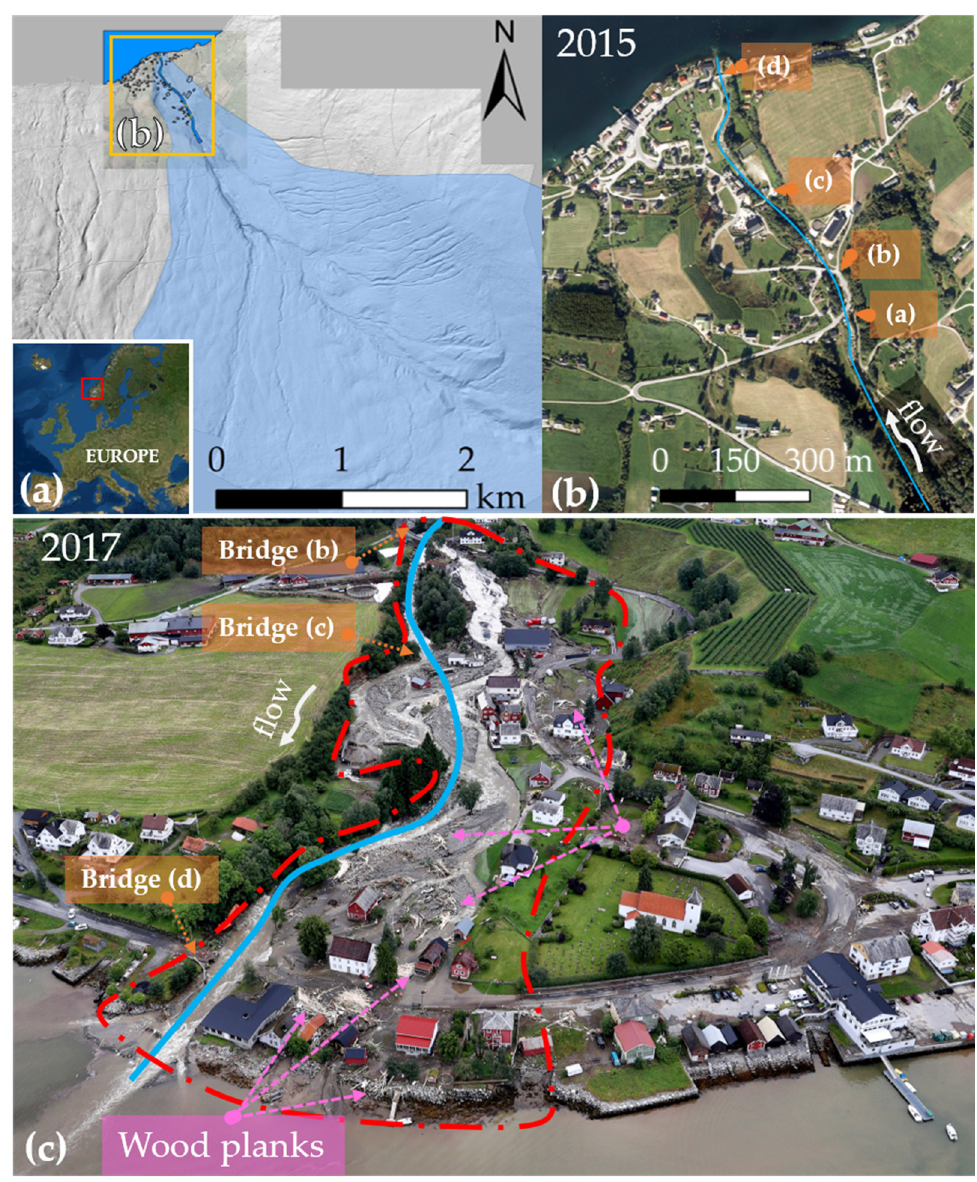
Figure 1. ( a ) Context map and catchment area [10] imposed over the hillshade of the hydrologic network of the Storelva river in Utvik (western Norway) [12], ( b ) aerial view of the area of interest before [16] and ( c ) during the flood (VG/H. Vågenes). Labels in ( d ) mark the bridges; original river thalwegs in blue lines; preferential flow zone during the flood marked by red dashed line.